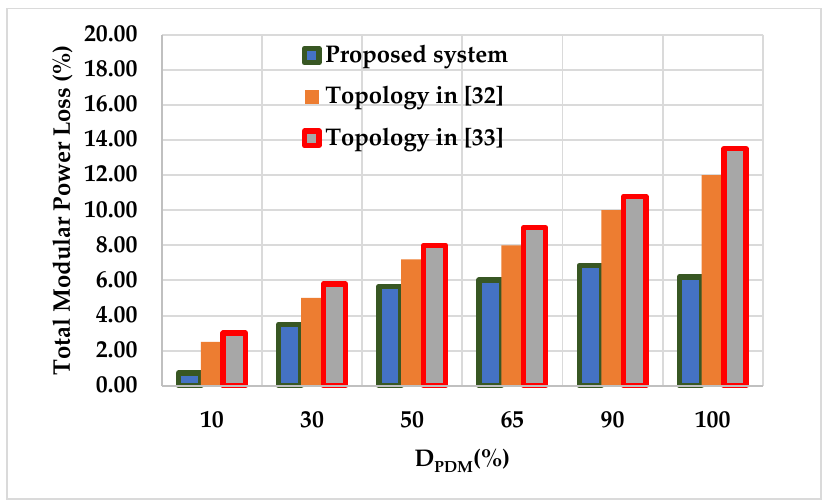
Figure 14. Total modular power loss.